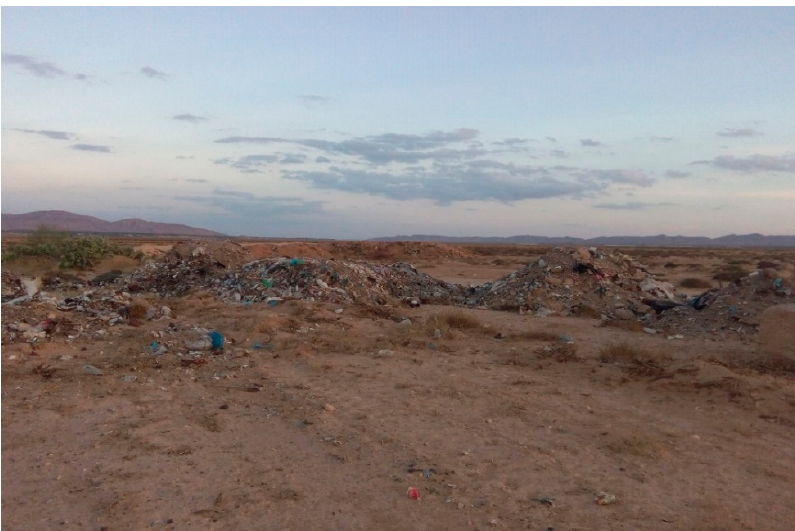
Figure 4. Dumpsites made of household waste adjacent to chenopod fields.